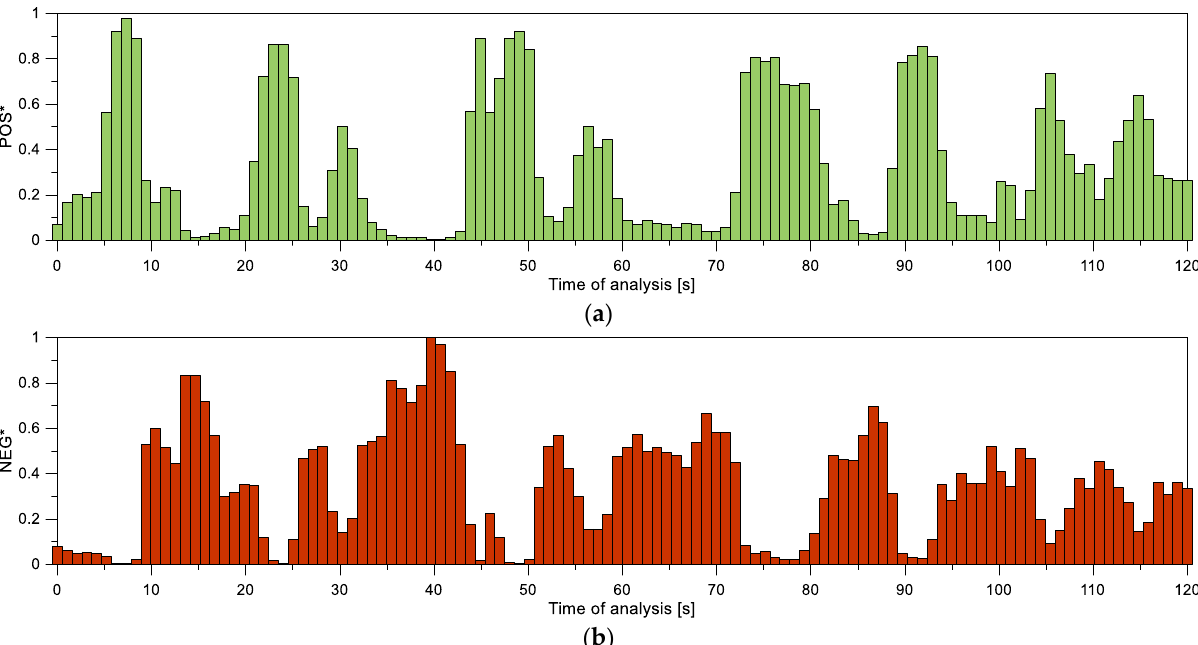
Figure 10. Example of calculated ( a ) POS* and ( b ) NEG* measurements of AU signals, as obtained for one of the participants under the VR input source, as a function of the time of analysis.